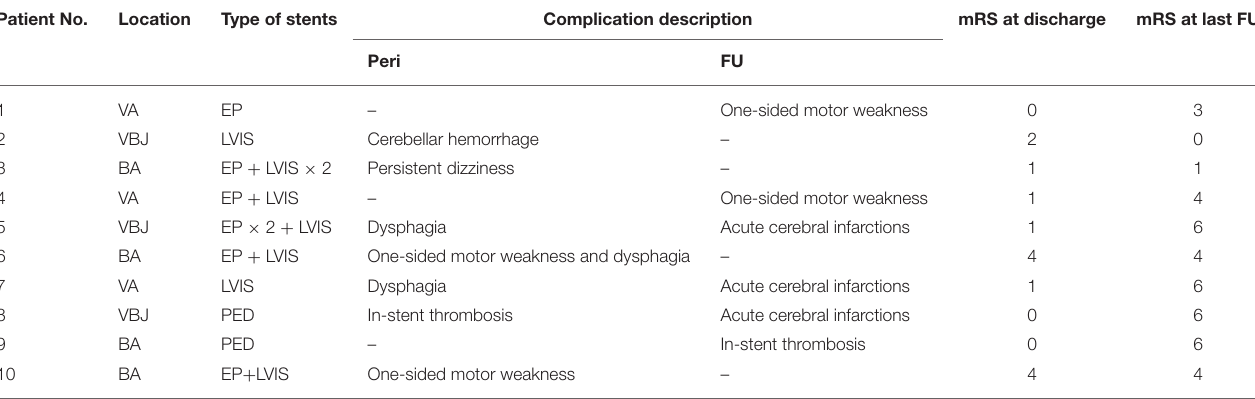
TABLE 3 | Baseline characteristics of patients with postprocedural complications. Patient